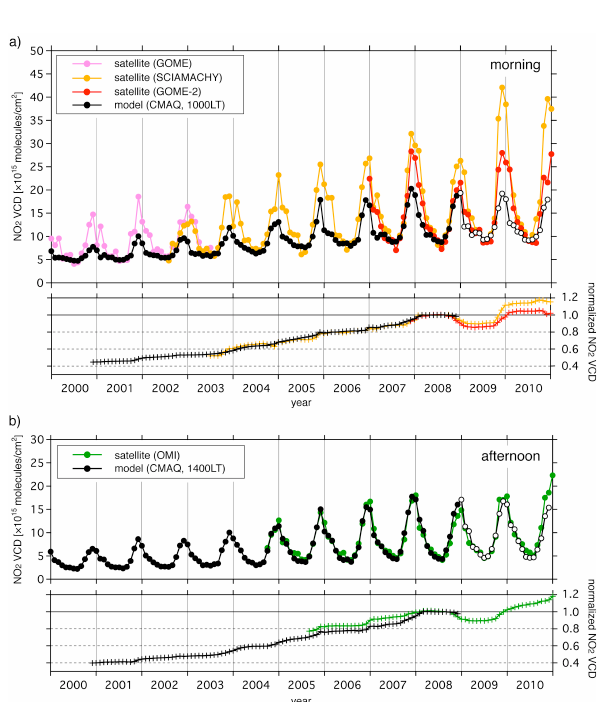
Fig. 1. Temporal variations in monthly mean tropospheric NO 2 VCD above the central eastern China (CEC) region during the period 2000–2010 from multisatellite observations (GOME, SCIAMACHY, GOME-2 and OMI) and model results (open circles denote sensitivity simulations with anthropogenic emissions fixed at 2008 values) in the (a) morning and (b) afternoon. The normalized tropospheric NO 2 VCD relative to averaged values between October 2007 and September 2008 with a 12-month moving average are also shown at the bottom.